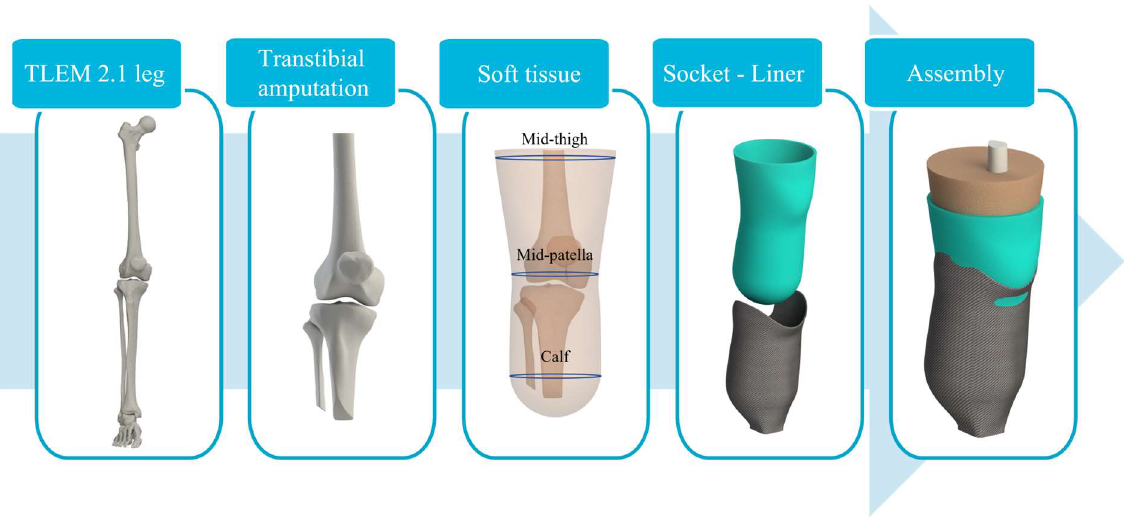
Figure 2. Modeling process of the generic numerical model geometry for the transtibial socket eval-